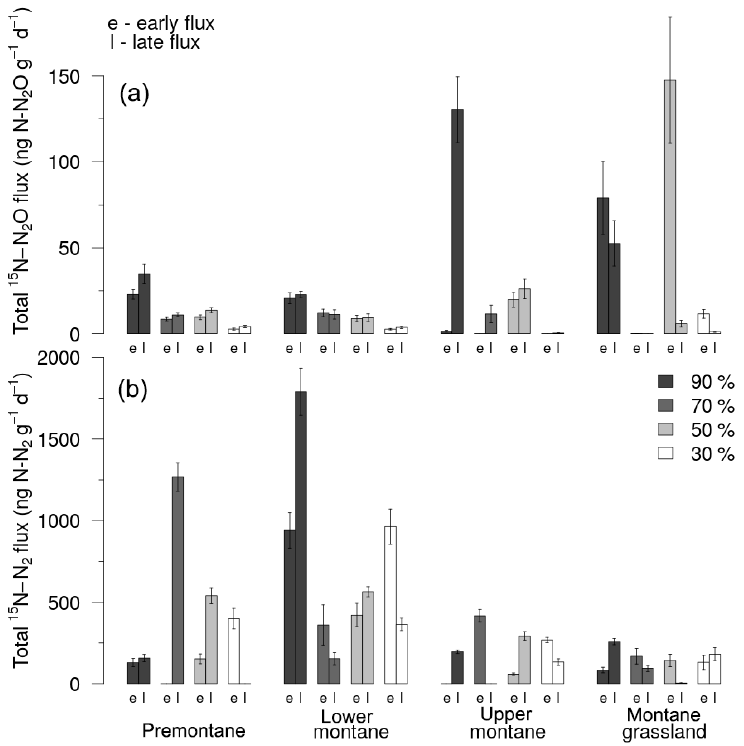
Figure 4. Total (a) 15 N–N 2 O flux and (b) 15 N–N 2 flux during the early ( ≤ 24h) and late ( > 24h) incubation phases of the water-filled pore space (WFPS) experiment. Results from the 90% WFPS treatment are shown in dark grey, while data from the 70, 50, and 30% WFPS treatments are shown in mid grey, light grey, and white, respectively. The bar charts show means and standard